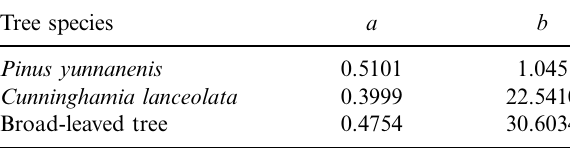
Table 3. The a and b values for calculation of M and